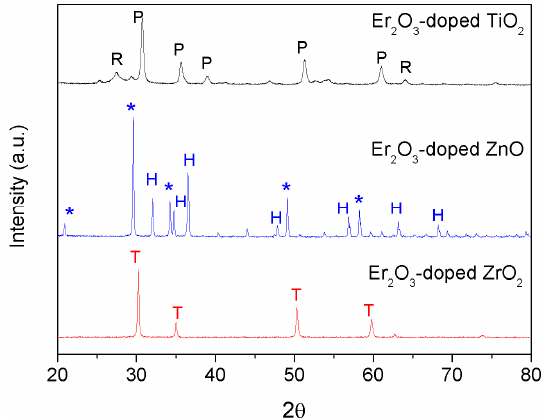
Figure 2. XRD patterns of the Er 2 O 3 -doped TiO 2 , ZnO, and ZrO 2 particles, with the reference patterns of the pyrochlore (P), rutile (R), hexagonal (H), Zn extra phase (*), and tetragonal (T) crystalline phases.